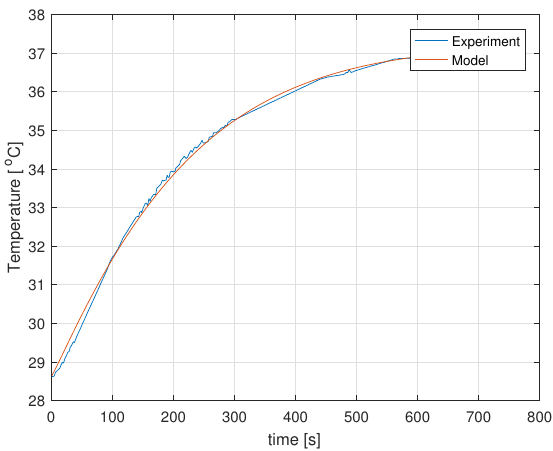
Figure 5. The step responses of the FO model and real plant for area 1.